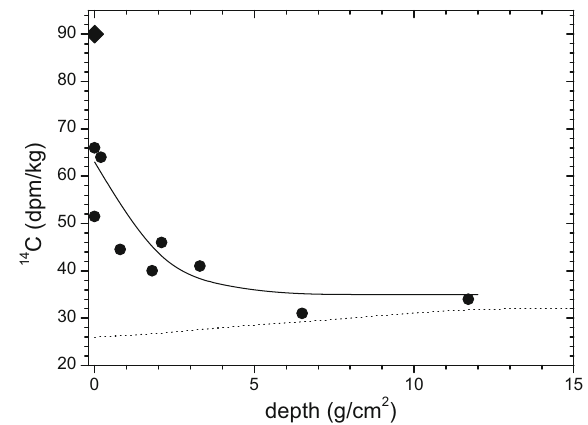
Fig. 28 Measured ( dots ) and calculated ( curves ) 14 C activity in a lunar sample 68815 (Jull et al. 1998). The big diamond implies contamination of a thin surface layer by 14 C implanted from solar wind. The dotted curve represents the expected production due to GCR, while the solid curve is the best fit SEP+GCR model production